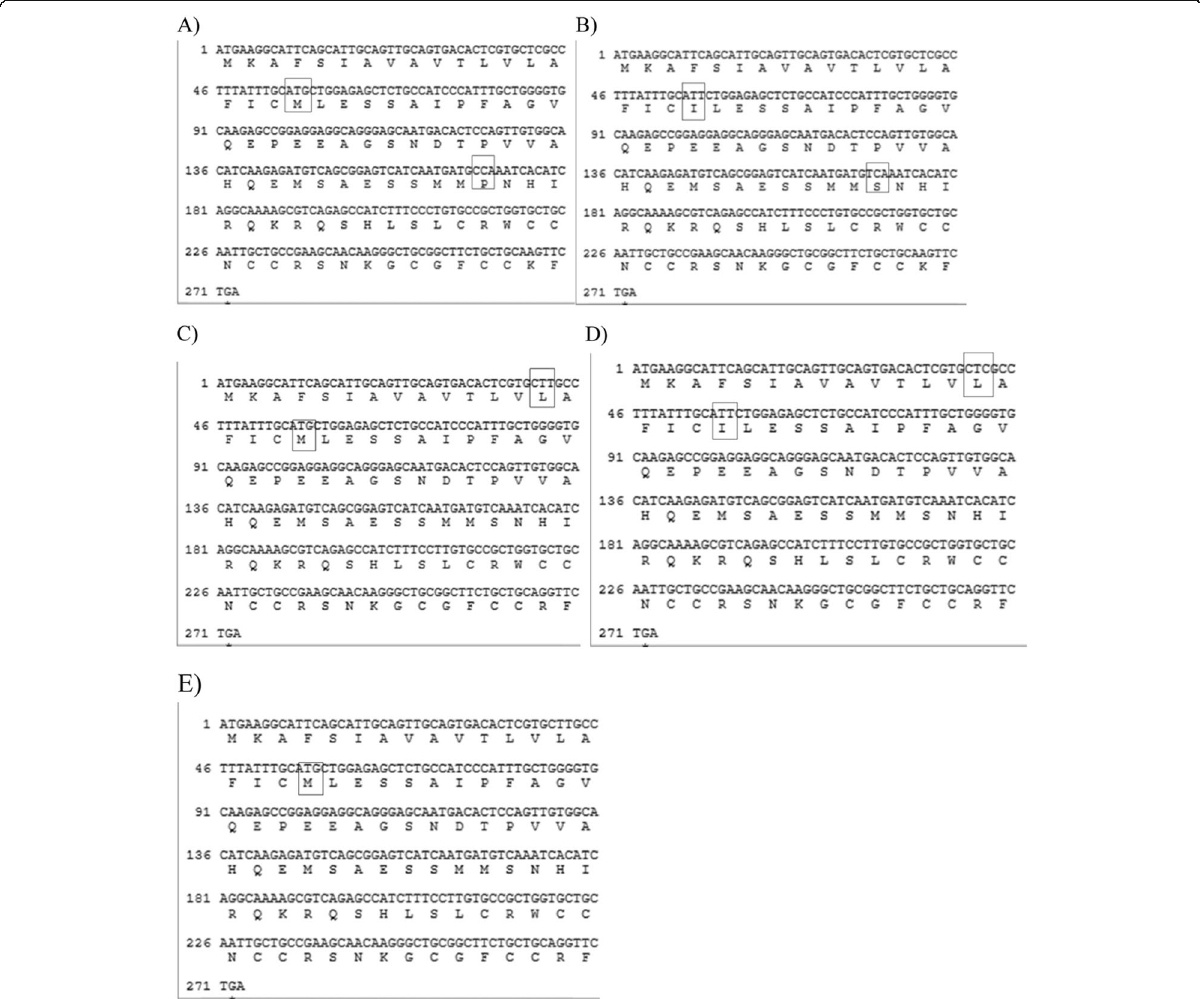
Fig. 7 a , b Nucleotide and amino acid sequences of different genotypes of T. zillii species. c , d Nucleotide and amino acid sequences of different genotypes of S. galilaeus species. e Nucleotide and amino acid sequence of O. niloticus